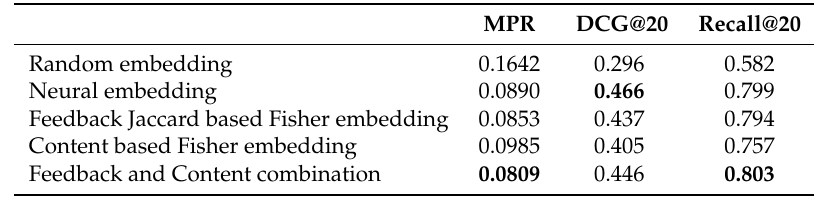
Table 7. Experiments on MovieLens with different input embeddings in Gru4Rec. Best performing methods are indicated in boldface.